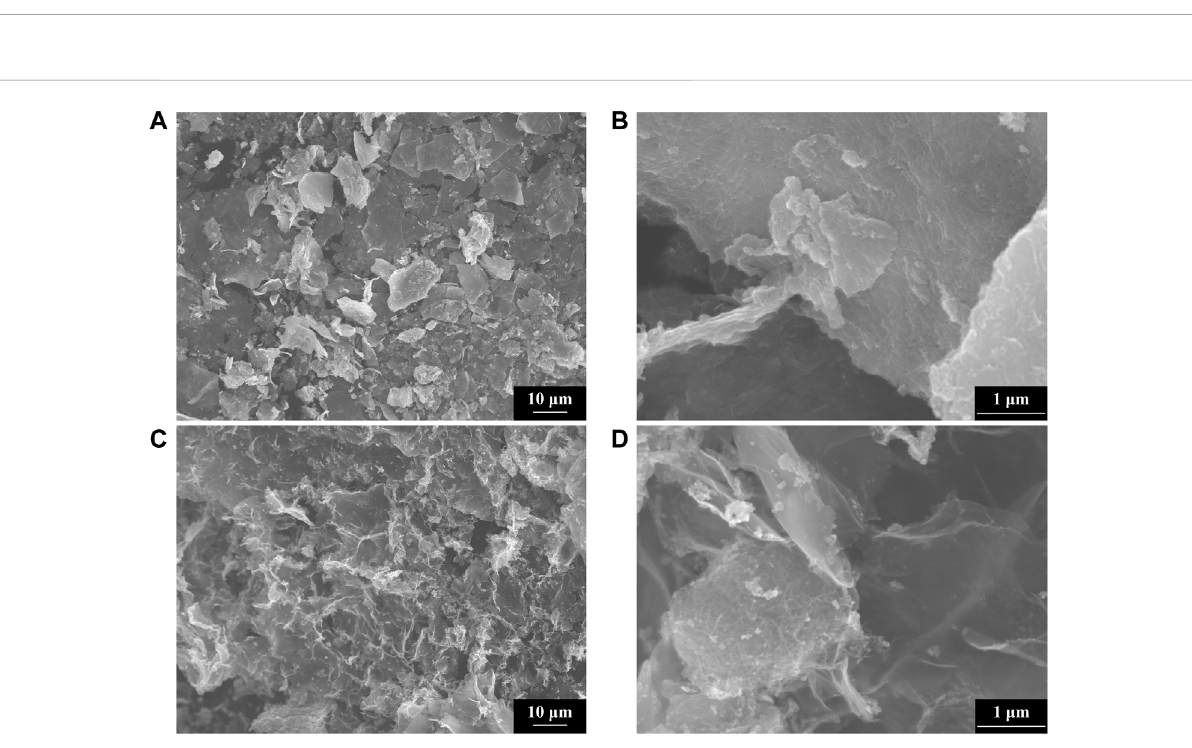
FIGURE 3 SEM of ZnO (sample A) at magni fi cations of (A) 1,000 and (B) 20,000 times. SEM of ZnO/G/GO/MCNT composite aerogel (sample C) at a multiplicity of (C) 1,000 and (D) 20,000